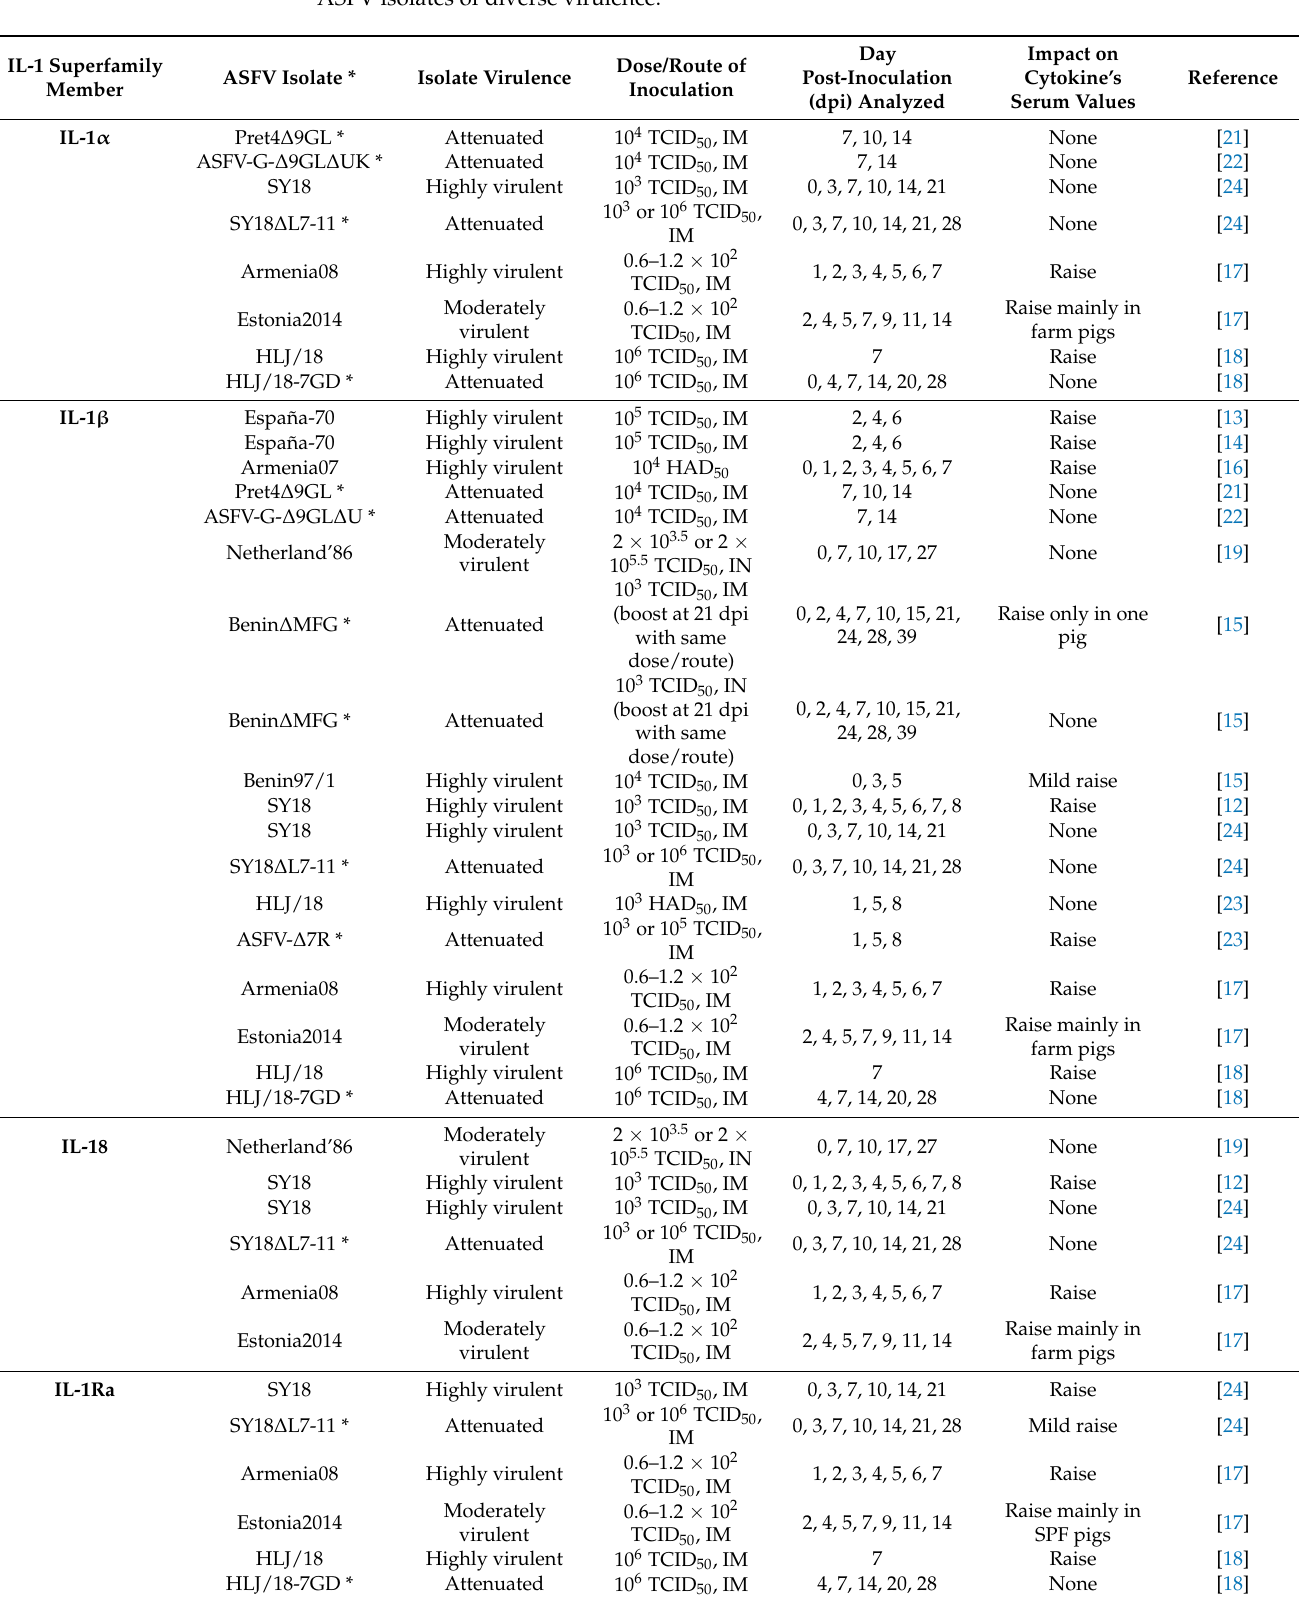
Table 1. Modulation of serum levels of IL-1 α , IL-1 β , IL-18, IL-1Ra in domestic pigs infected with ASFV isolates of diverse